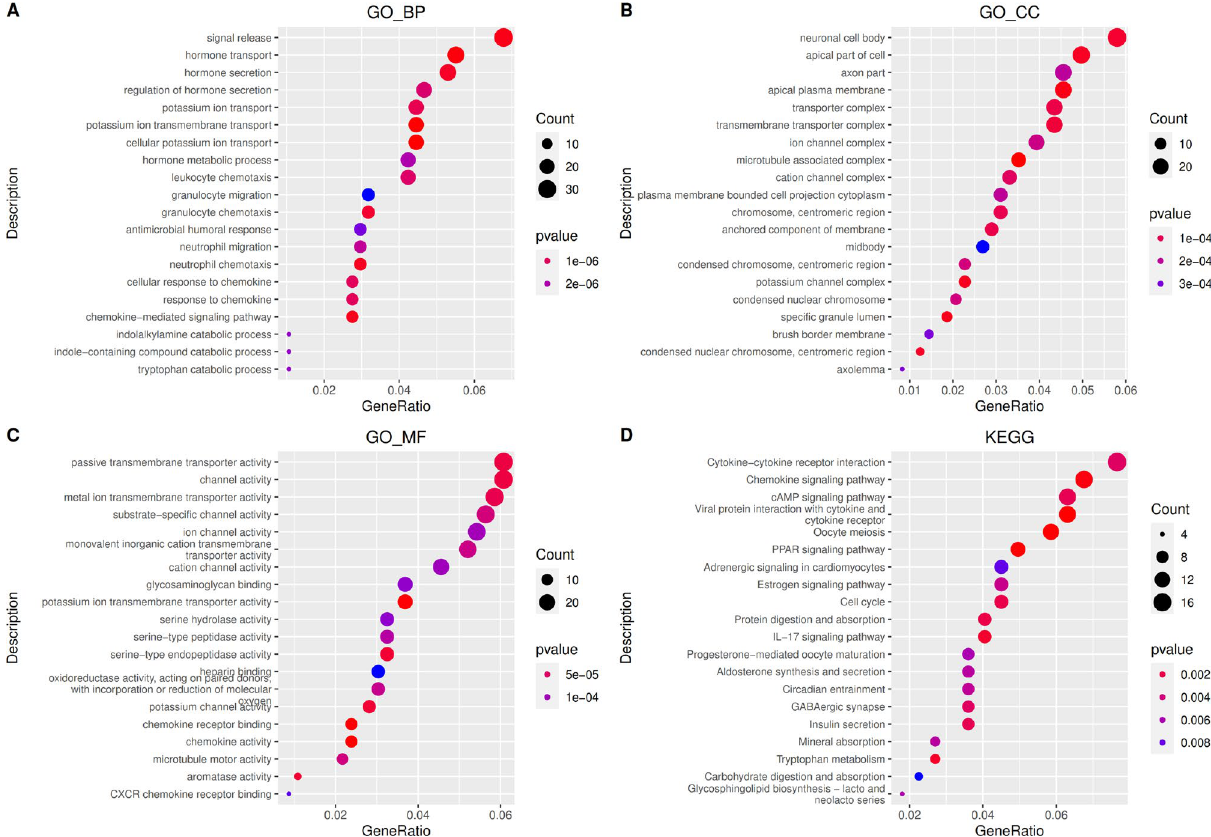
Figure 5. Differential gene function and pathway enrichment analysis results (top 20 with significant differences). ( A ) Biological process (BP); ( B ) Cellular component (CC); ( C ) Molecular function (MF); ( D ) Kyoto Encyclopedia of Genes and Genomes(KEGG) pathway enrichment